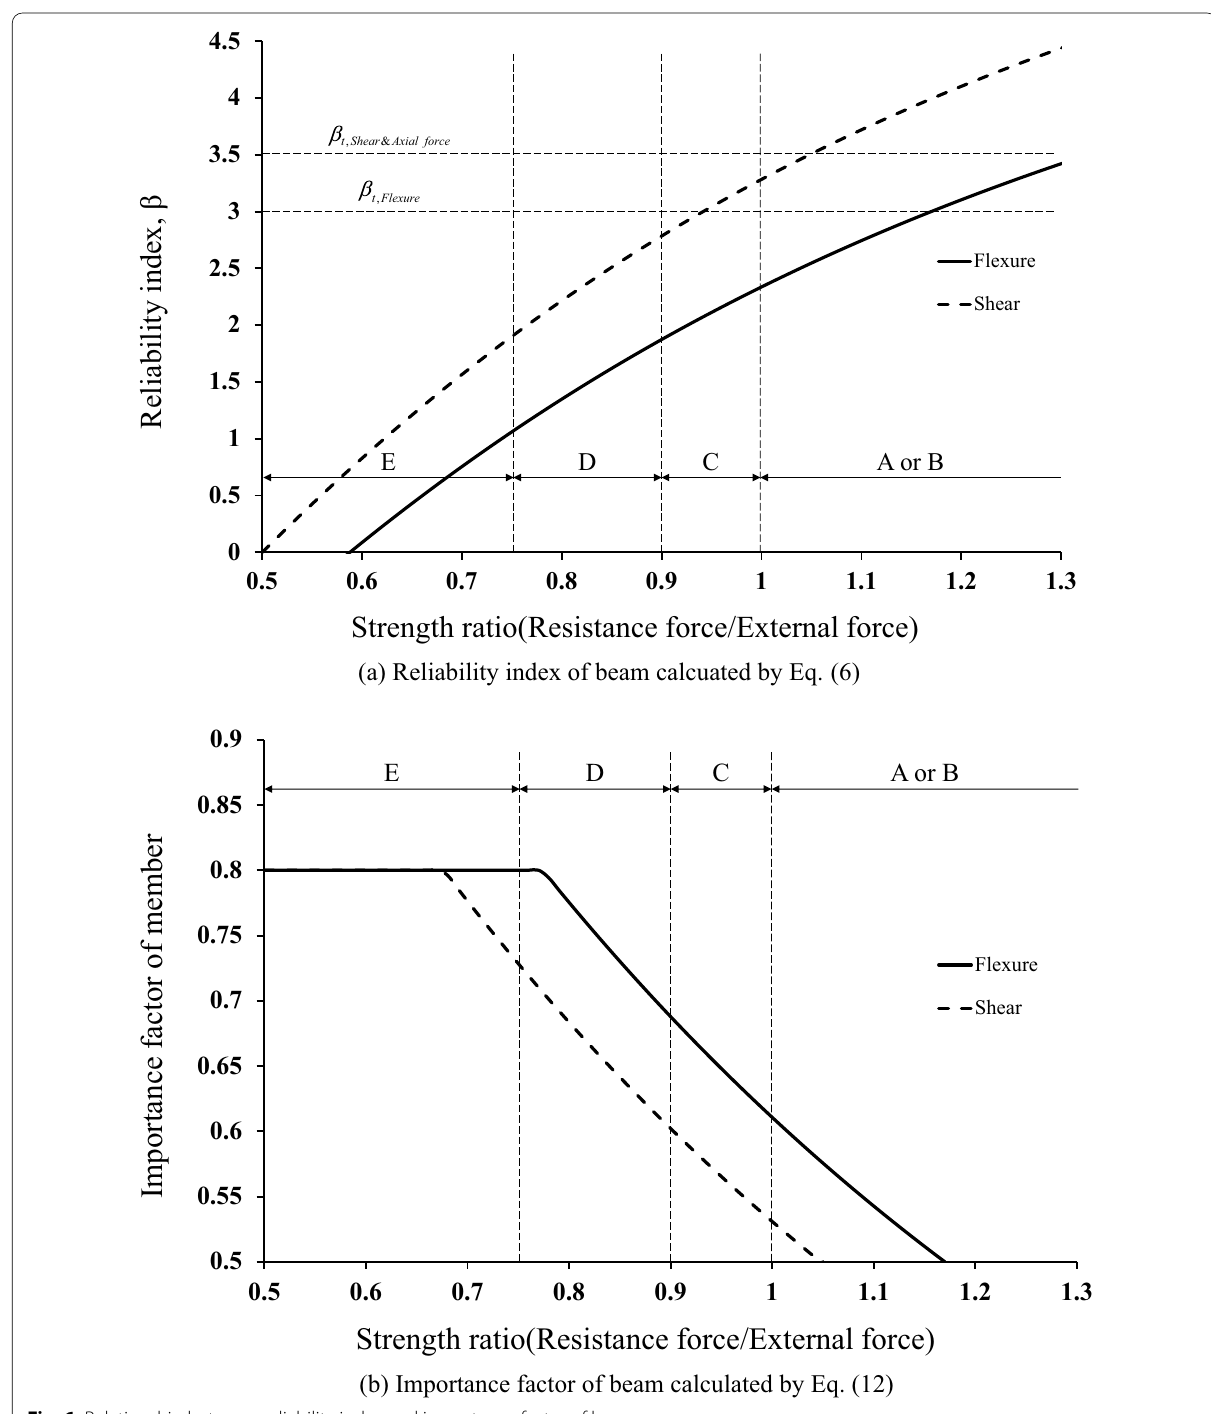
Fig. 6 Relationship between reliability index and importance factor of